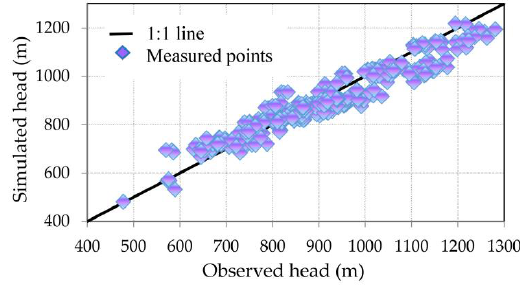
Figure 6. Calibration graph for MODFLOW performance, comparing simulated hydraulic head values to the observed hydraulic head values at each observation well. Similar graphs can be displayed at any time step throughout the simulation